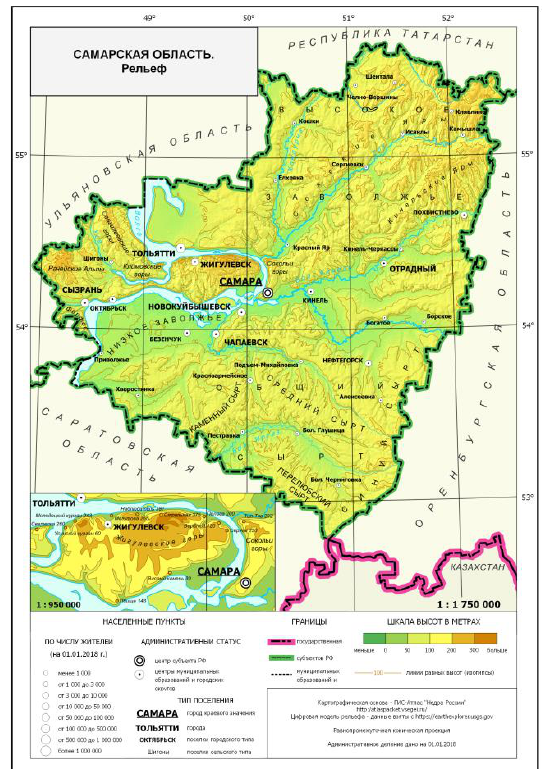
Figure 6. Final relief map of Samara Region